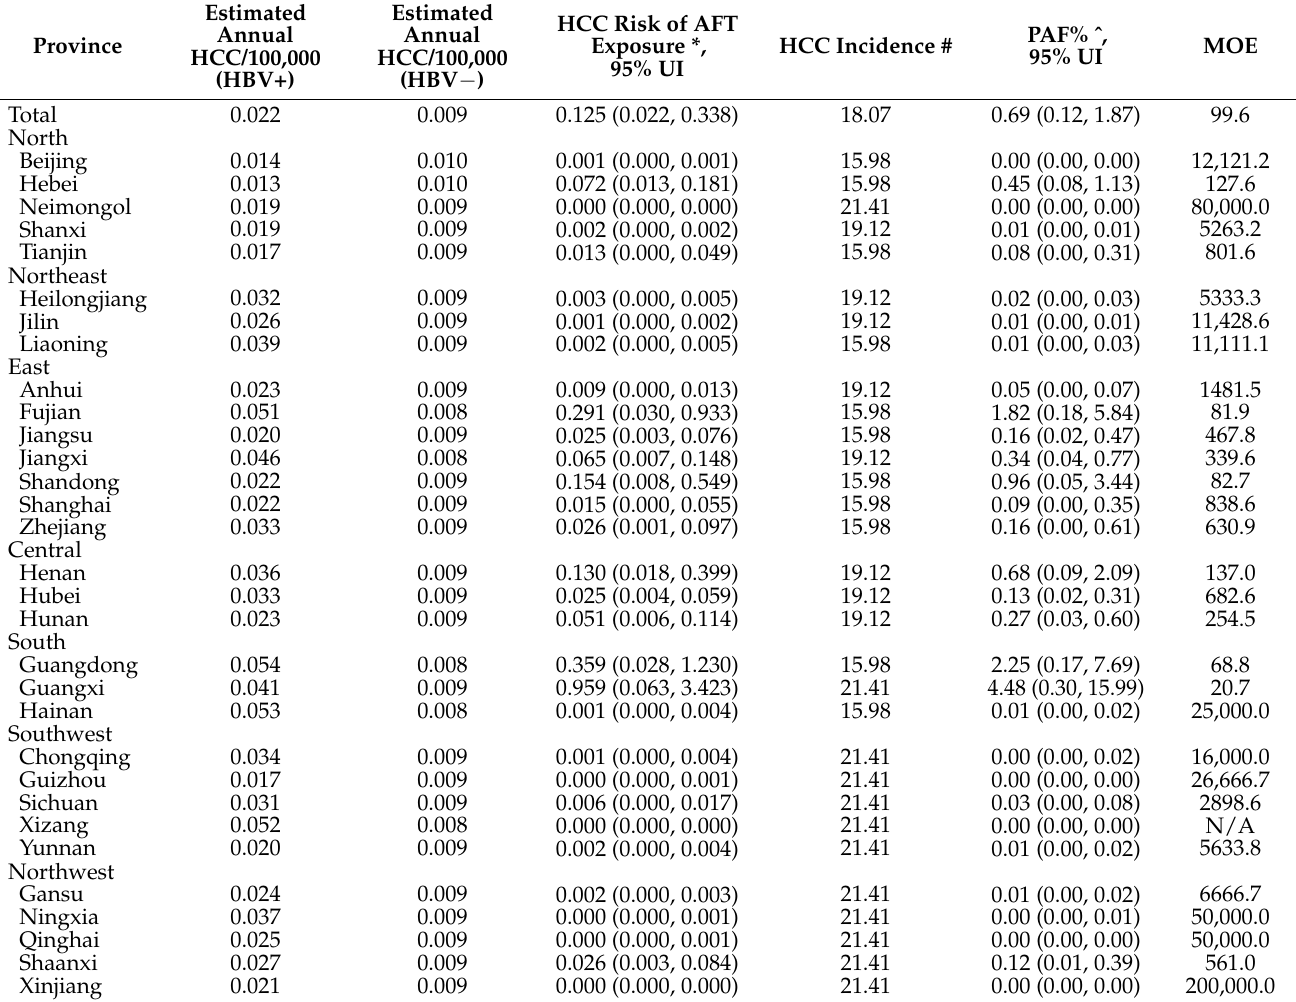
Table 4. The HCC risk, PAF, and MOE of AFT exposure from peanuts, peanut oil, corn, and corn